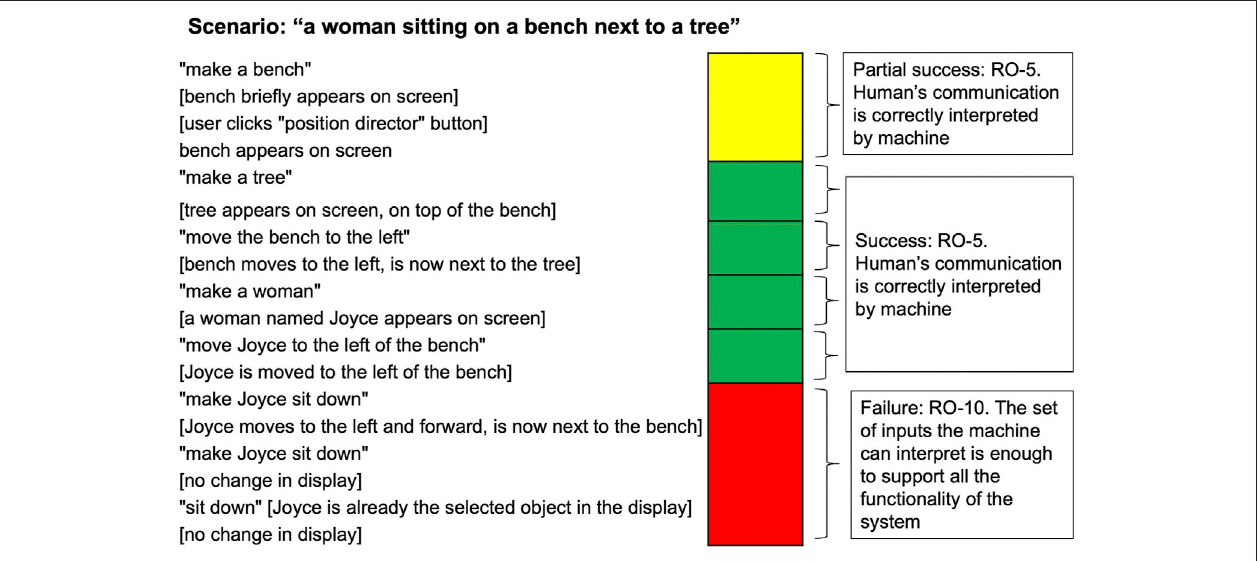
FIGURE 7 | Robustness assessment of a simple interaction in the Aesop system: On the left of the fi gure are human utterances (in quotation marks) paired with descriptions (in square brackets) of the state of the screen where the characters and scene are being built. In addition to the Hallmarks annotated in the image, this interaction demonstrates an overall success on Hallmark RO-1.